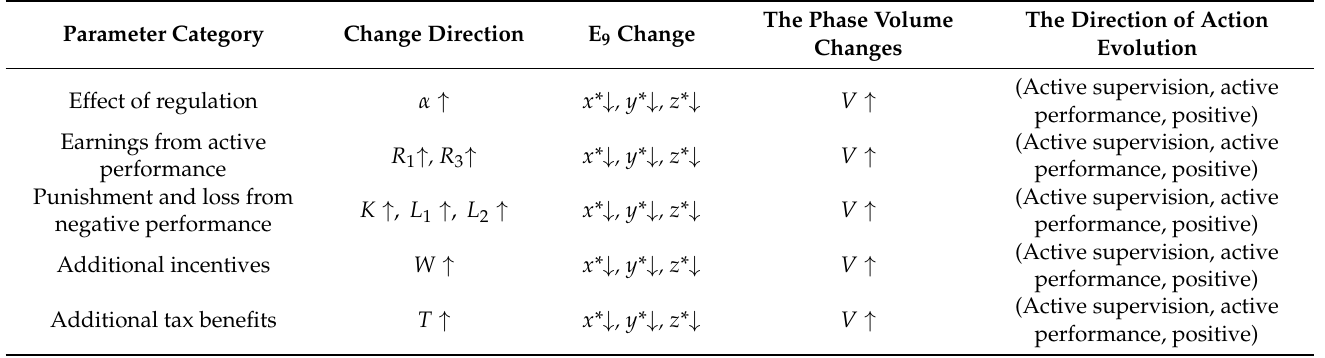
Table 6. The effect of the parameter changes on the action